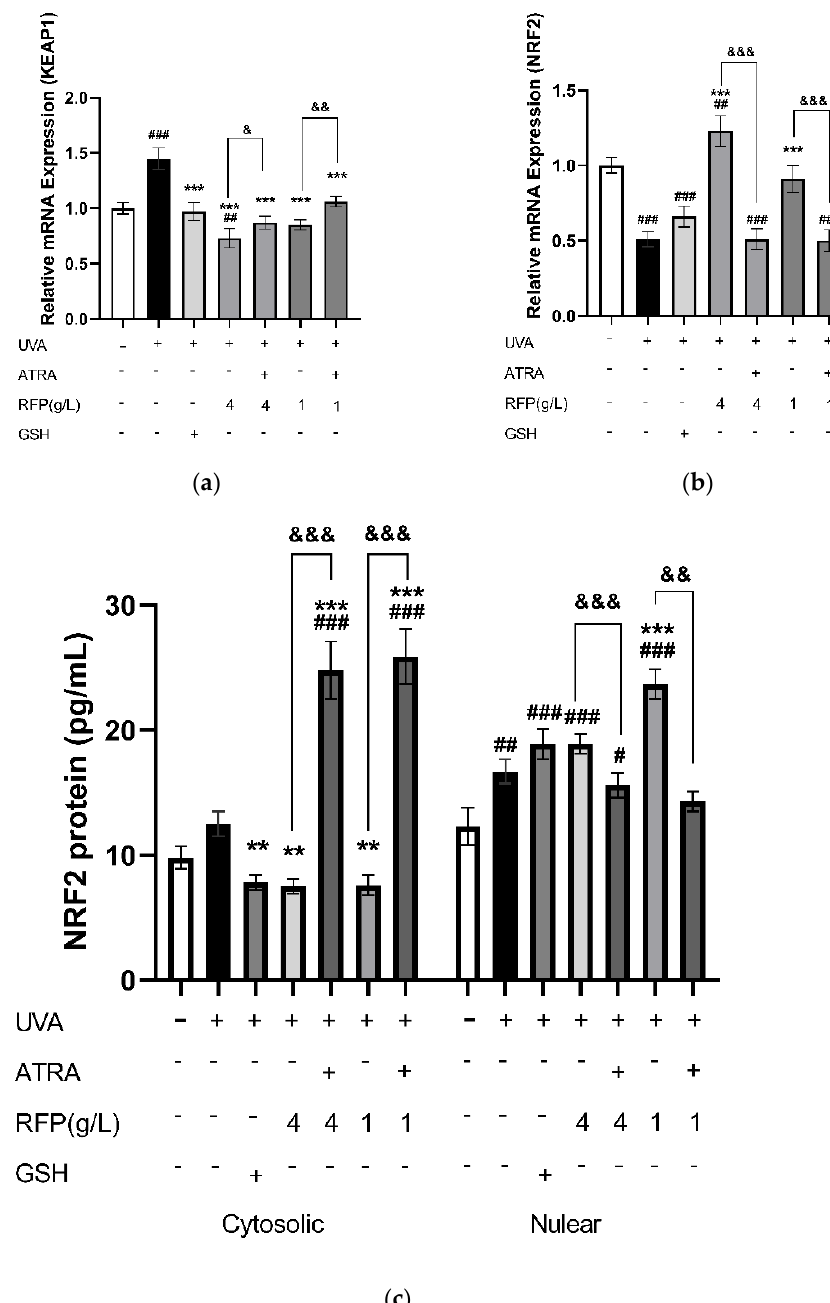
Figure 6. Effects of RFP on nuclear translocation of NRF2: ( a ) effect on relative expression of KEAP1; ( b ) effect on relative expression of NRF2; and ( c ) effect on protein content of cytoplasm and nucleus NRF2. # p < 0.033, ## p < 0.002, ### p < 0.001 as compared to control group; ** p < 0.002, *** p < 0.001